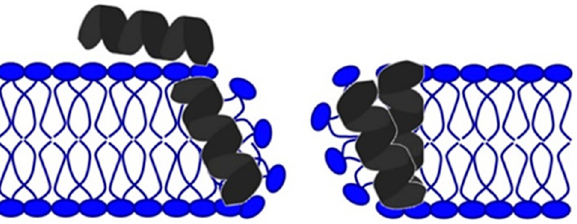
Figure 3. Toroidal pore model.